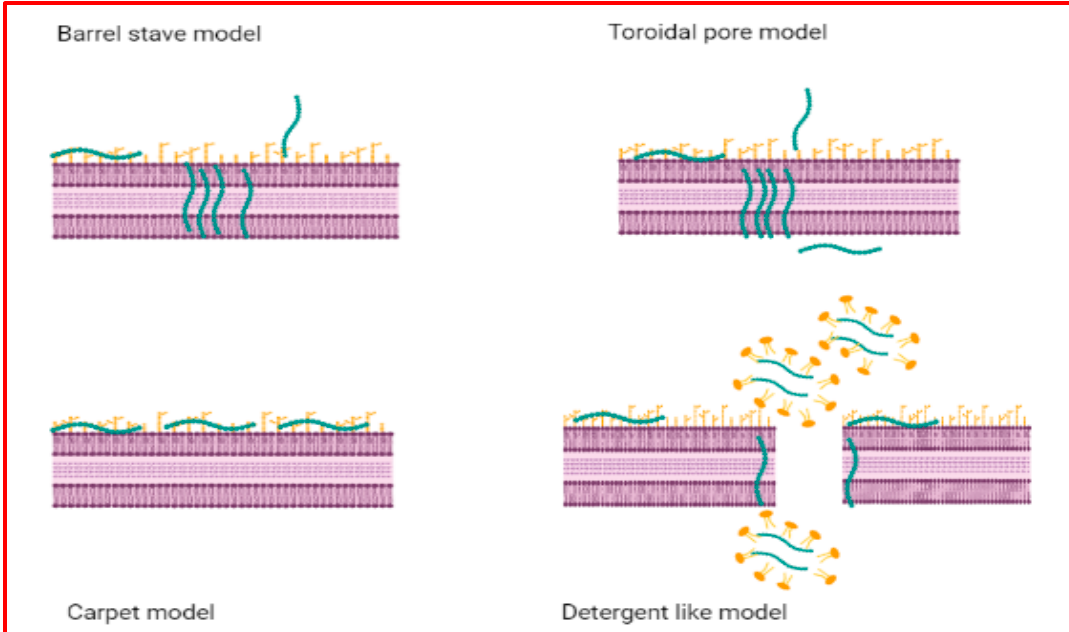
Figure 6. The AMP mechanisms of action on cell